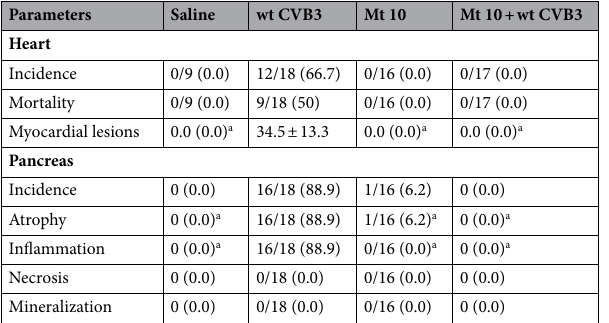
Table 2. Histological evaluation of hearts and pancreata in saline, wt CVB3, Mt 10-infected, and Mt 10-infected and challenged mice. () Indicates percentages. a Denotes significant differences in comparison with wt CVB3 group ( p <